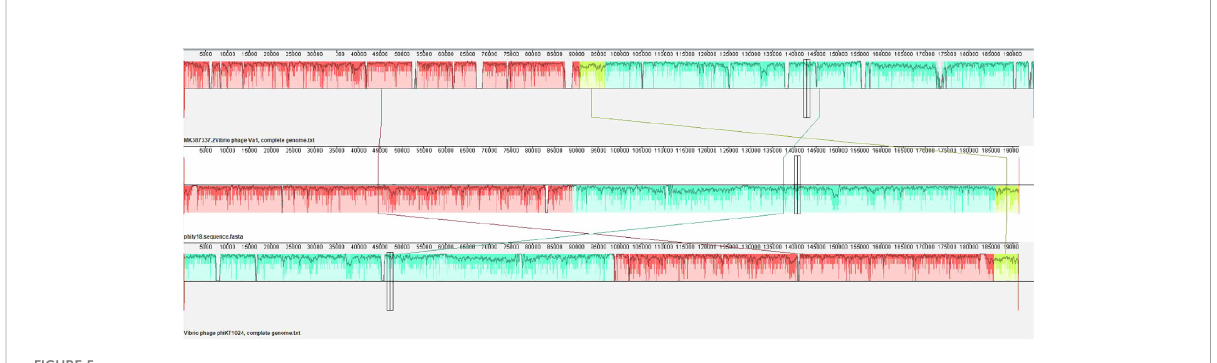
FIGURE 5 Collinear analysis of phage phiTY18 with Vibrio phage phiVa1 and phiKT1024. The collinearity analysis of three phages Va1, phiTY18 and phiKT1024 are shown. The same color indicates that this part of the sequence is